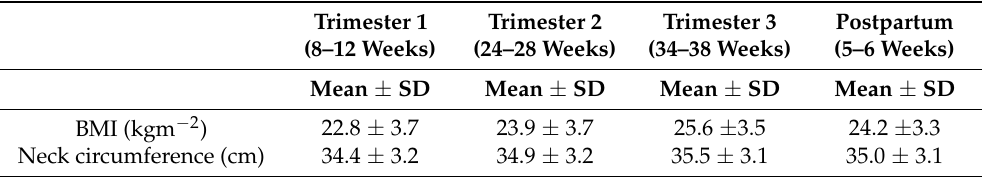
Table 2. Change in the body mass index (BMI) and neck circumference in women from the first trimester to postpartum